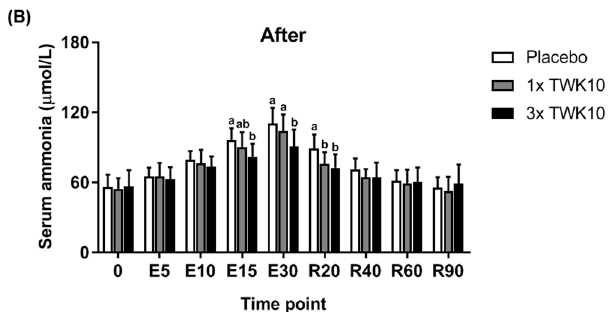
Figure 5. TWK10 reduced the content of serum ammonia during and after exercise. During fixed intensity and period exercise tests, blood samples were collected for ammonia measurements at indicated time points. The contents of serum ammonia were assessed ( A ) before and ( B ) after TWK10 administration. Data are shown as the mean ± SD. Statistical di ff erences among groups were analyzed